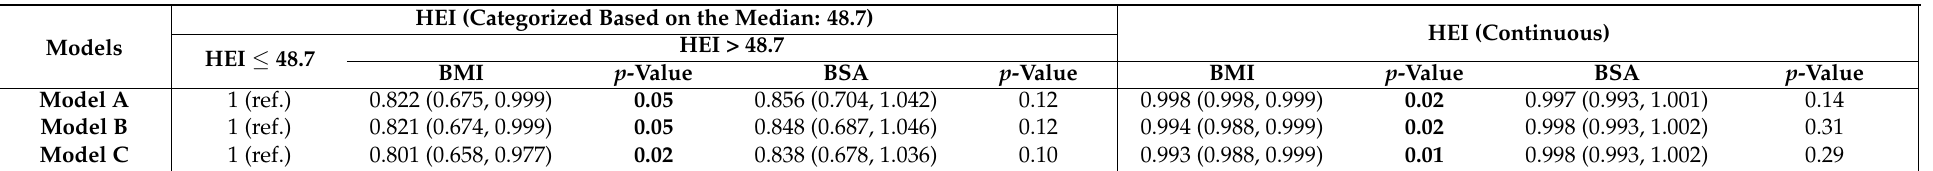
Table 5. Multivariable logistic regression (ORs and 95% CI) of the associations between HEI (as a continuous and categorical variable) and obesity/overweight categories * ( n =